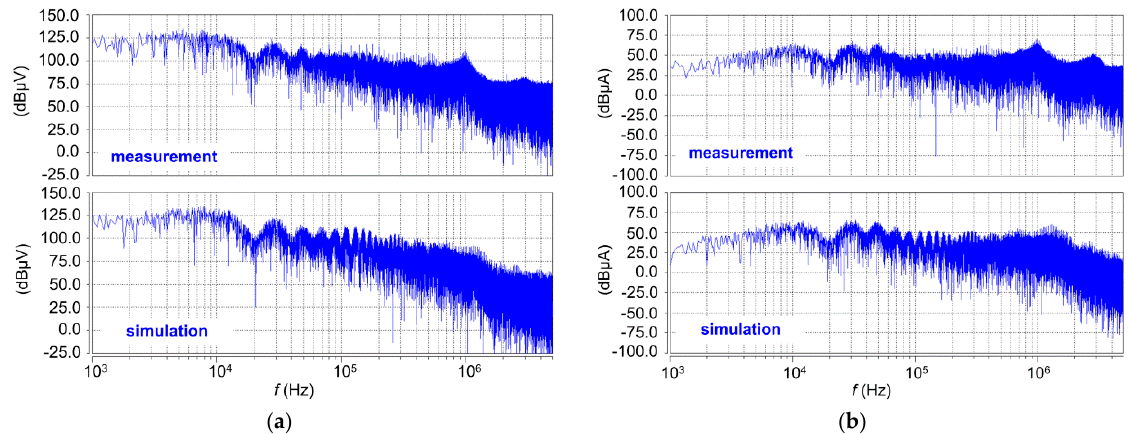
Figure 17. Simulated and measured spectra: ( a ) voltage v N-PE ; ( b ) current i PE .